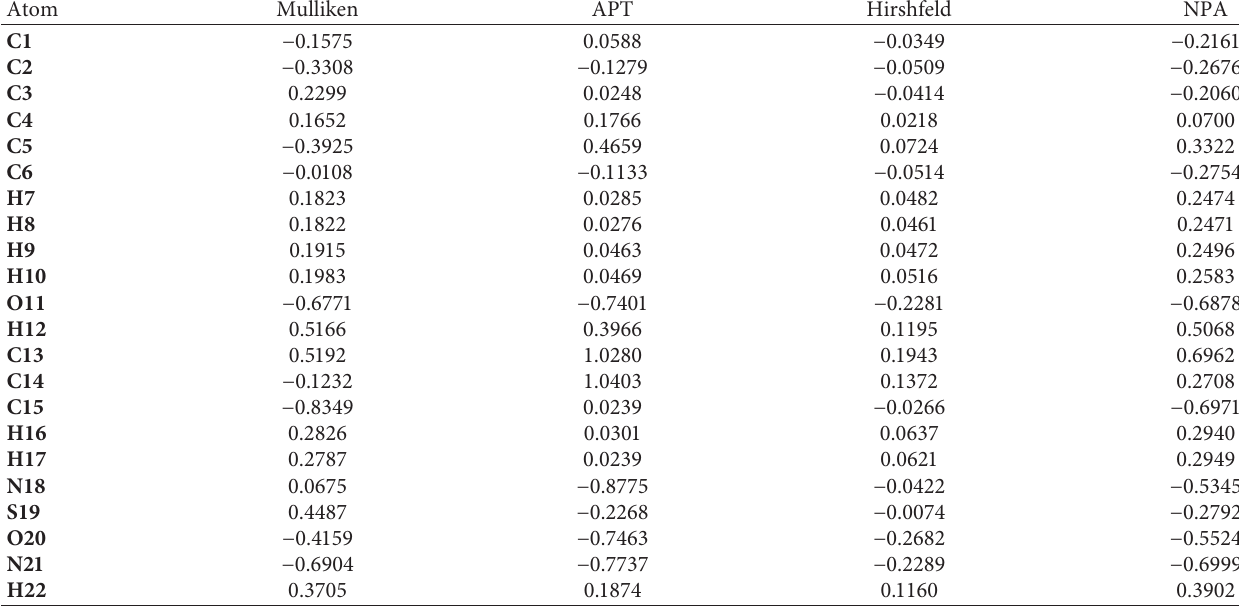
Table 5: Various theoretical atomic charges on L1.